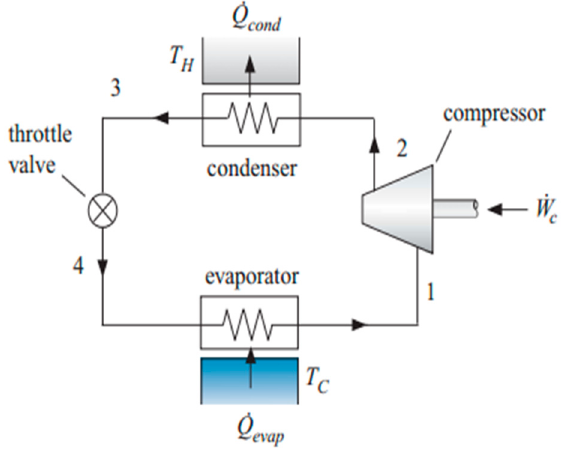
Figure 1. Schematic diagram of vapor compression cycle. (state 1: evaporator outlet and compressor inlet, state 2: compressor outlet and condenser inlet, state 3: condenser outlet and expansion valve inlet, state 4 (expansion valve outlet and evaporator inlet). Table 2. Input parameters.